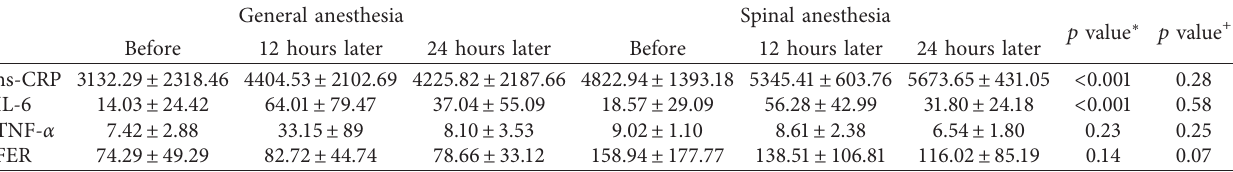
Table 1: The pattern of changes of inflammatory cytokines during the study period and between